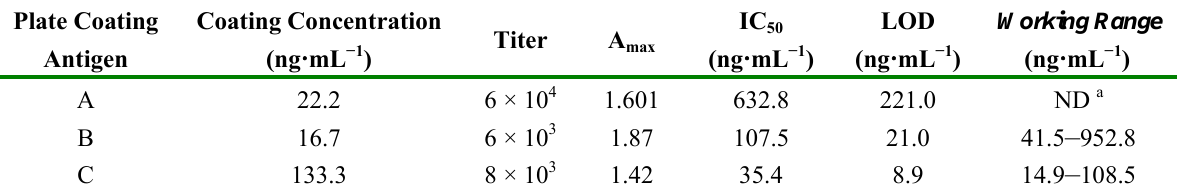
Table 1. Analytical characteristics for melamine based on different coating